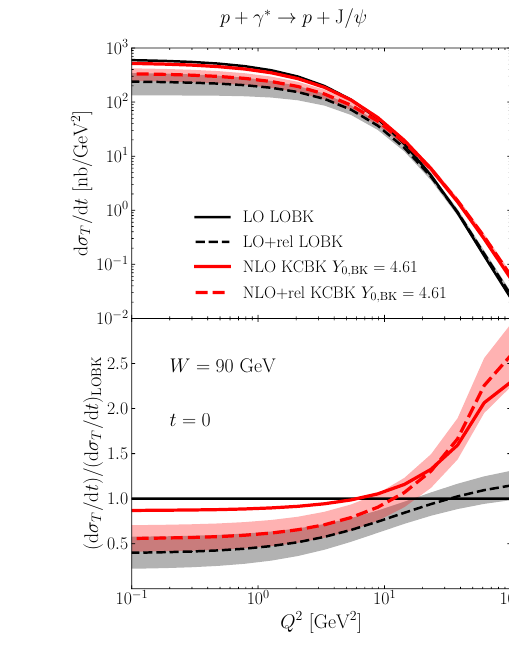
(a) Comparison of results with different (b) Comparison of the relativistic and next- dipole amplitudes. to-leading order corrections. Figure 3. Differential cross section for transverse J /ψ production at next-to-leading order. In the case of TBK evolution the rapidity values correspond to the target rapidity η . The uncertainty bands are obtained by taking into account the uncertainties of the NRQCD matrix